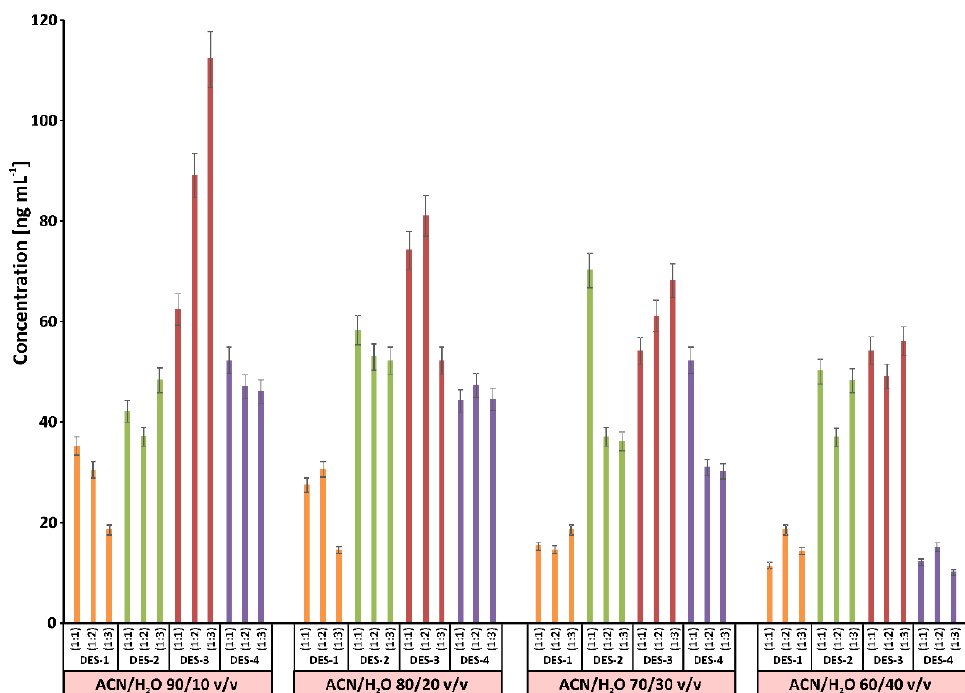
Figure 3. Influence of coating DES-based sorbent prepared with DES-1 (orange), DES-2 (green), DES-3 (burgundy) and DES-4 (violet) each in molar ratios 1:1, 1:2, 1:3 and desorption solvent (ACN/H 2 O in different volume ratios) on analytical signals of formaldehyde derivative obtained by the DES-TF-SPME/HPLC-UV-Vis method. The measurements were performed using 200 mL sam- ples containing 125 ng mL − 1 of formaldehyde derivative. Conditions: extraction time 30 min with the addition of 0.05 mg L − 1 NaCl and desorption for 12 min ( n =